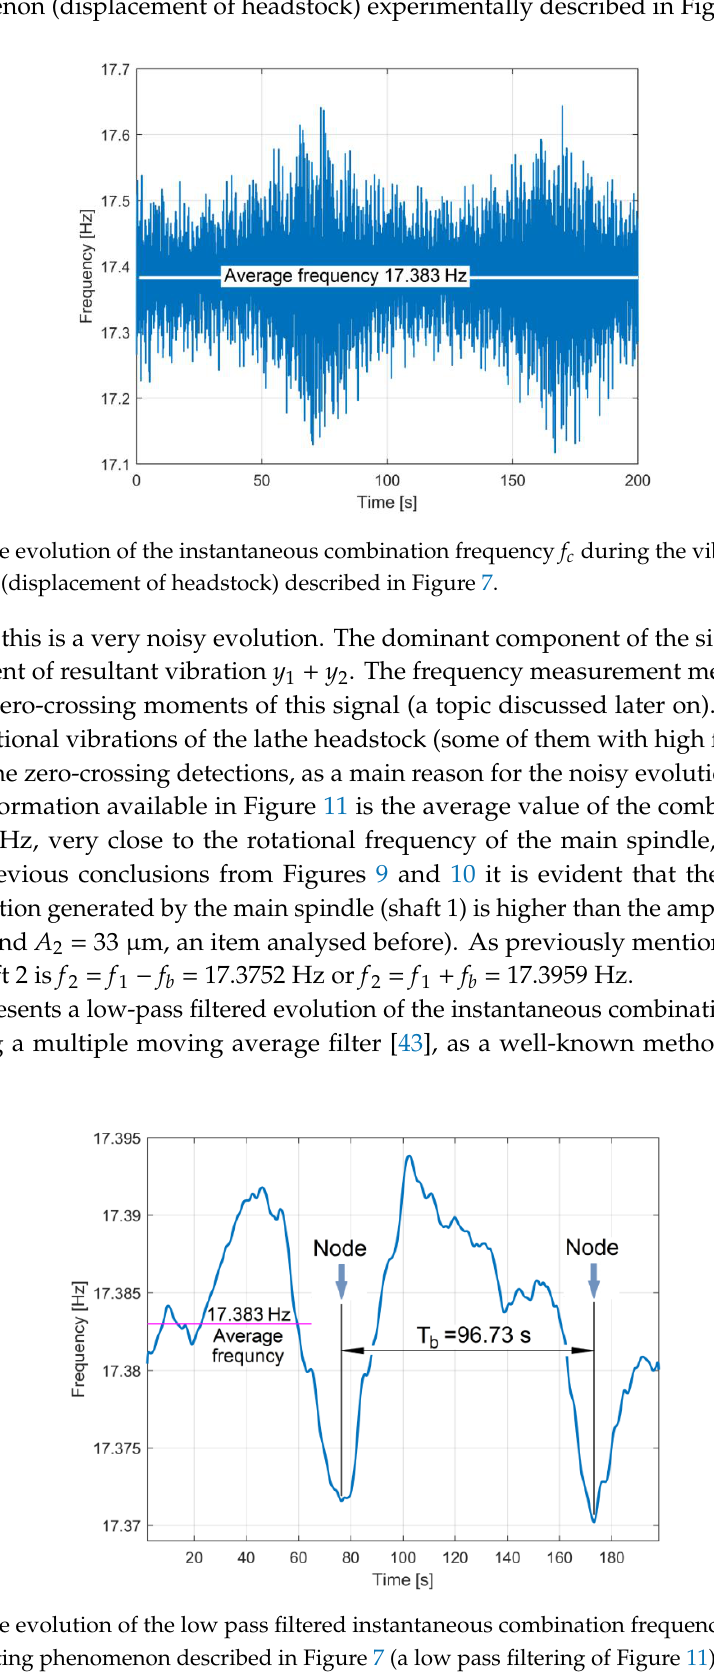
Figure 12. The evolution of the low pass filtered instantaneous combination frequency f c during the vibration beating phenomenon described in Figure 7 (a low pass filtering of Figure